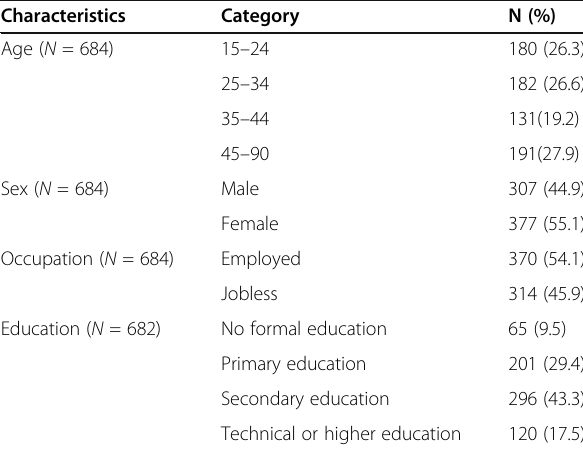
Table 1 Selected socio-demographic characteristics of study participants for SARS-C-oV-2 seroprevalence, Dire